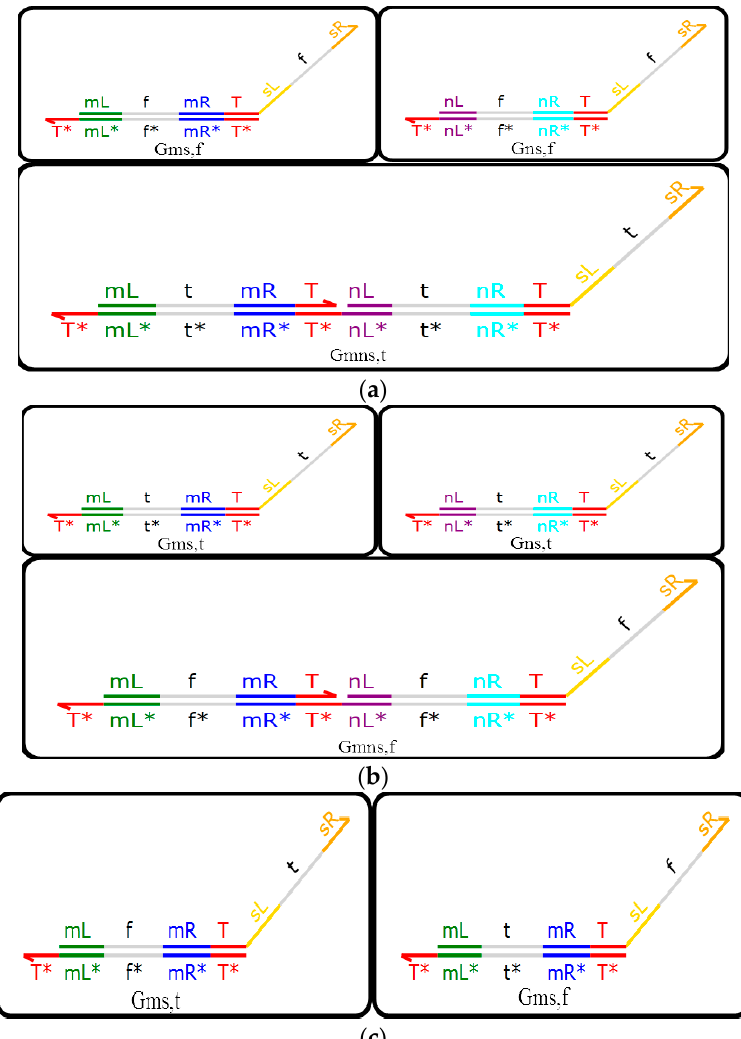
Figure 3. ( a ) The AND Gate module with a domain label; ( b ) the OR Gate module with a domain label; ( c ) the NOT Gate module with a domain label.